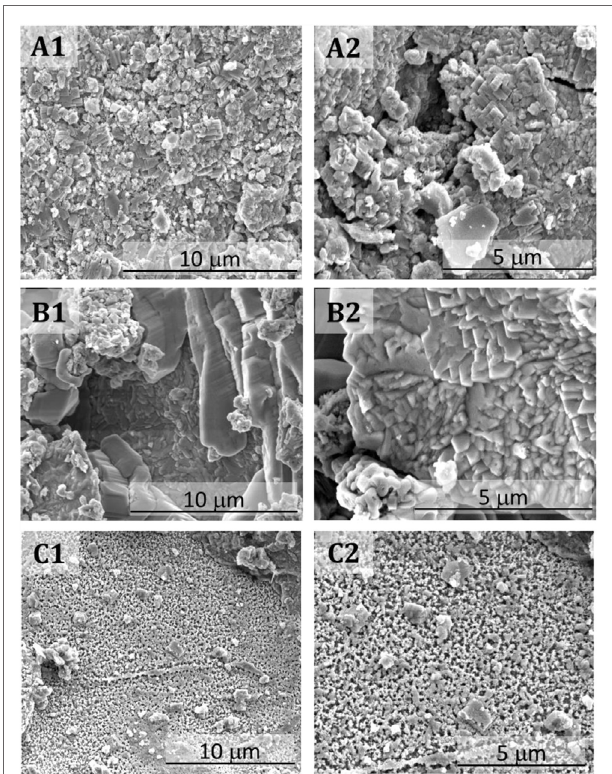
FigUre 5 | secondary electron micrographs of fractured carbonated alkali-activated slag/metakaolin binders with gbFs/(gbFs + MK) ratios of (a1,a2) 1.0, (b1,b2) 0.9, and (c1,c2) 0.8